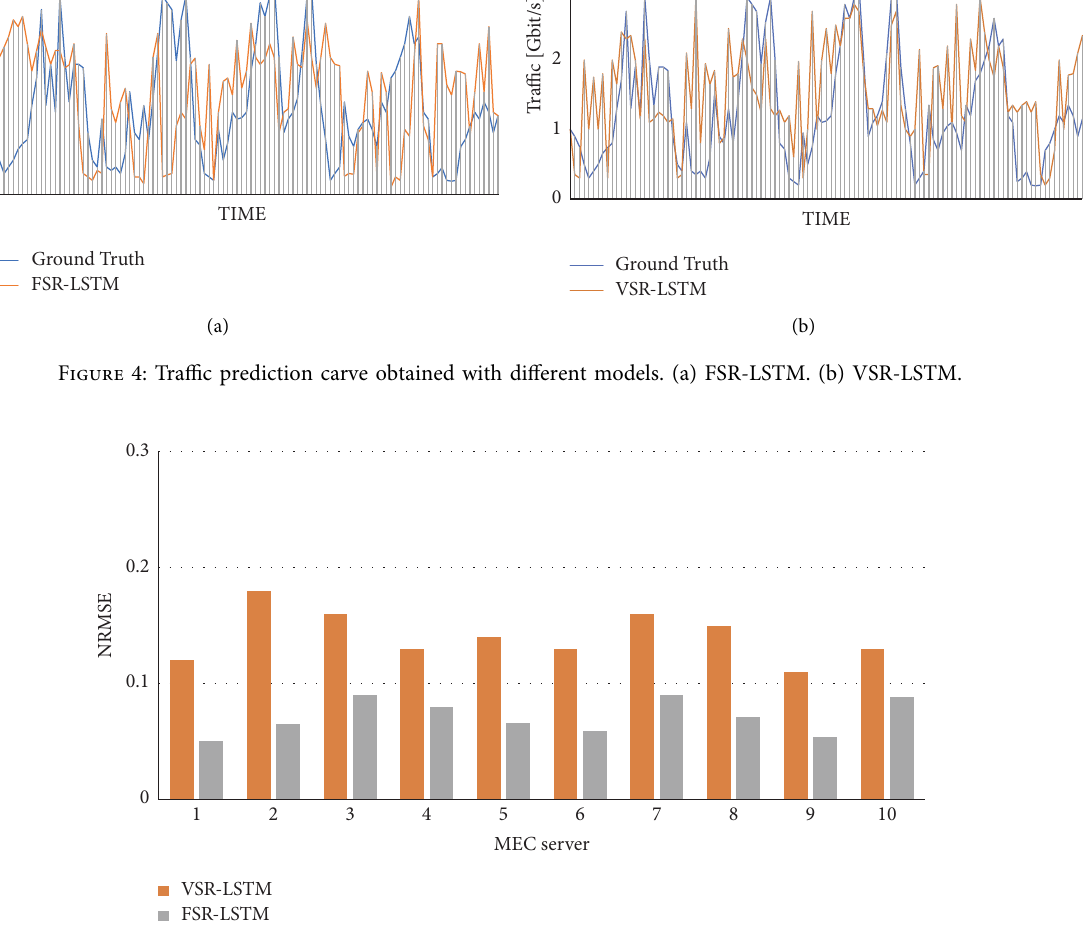
Figure 5: Trafc prediction errors obtained with diferent